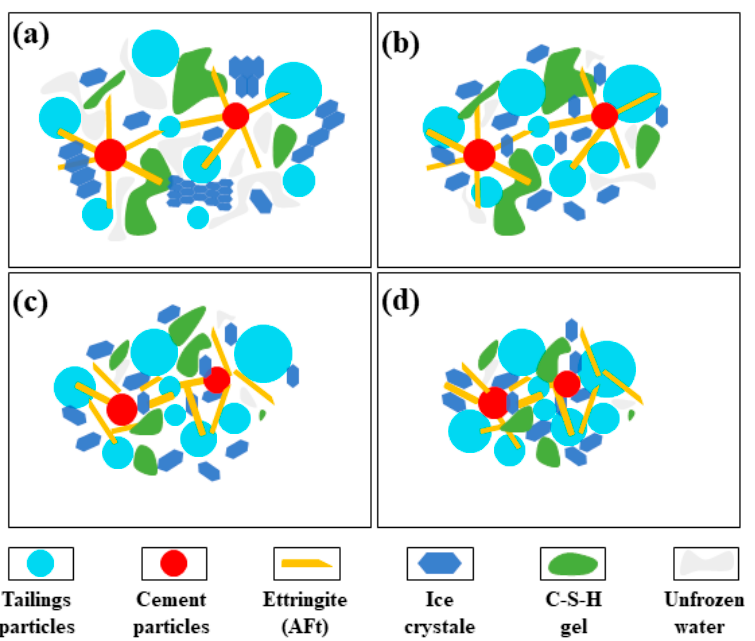
Figure 9. Failure process of frozen CTB (the frozen CTB is a mixture of tailings particles, cement particles, ettringite, ice crystale, C-S-H gel, unfrozen water).